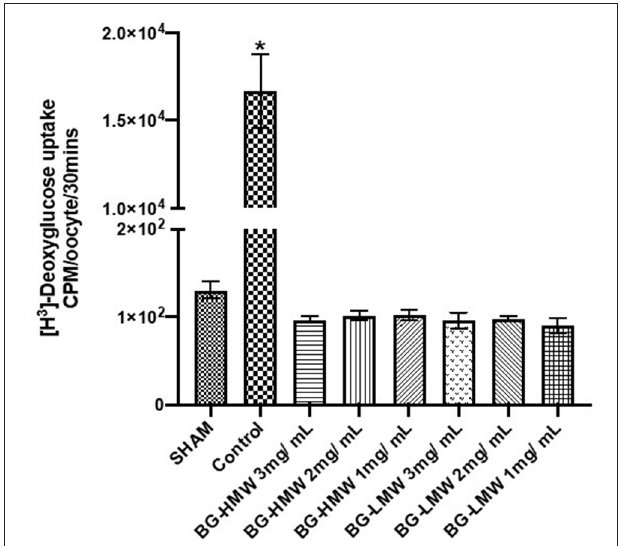
FIGURE 3 | Effect of BG on glucose uptake in oocytes expressing human GLUT2. Oocytes expressing human GLUT2 and oocytes injected with water (SHAM, negative control) incubated in buffer containing radiolabeled glucose only (control) or buffers containing different amounts barley BG (BG-HMW: 650,000 average molecular weight; BG-LMW: 229,000 average molecular weight). Data are mean + SEM ( n = 12–15 oocytes per treatment). *Significantly different from all other treatment groups p < 0.0001.